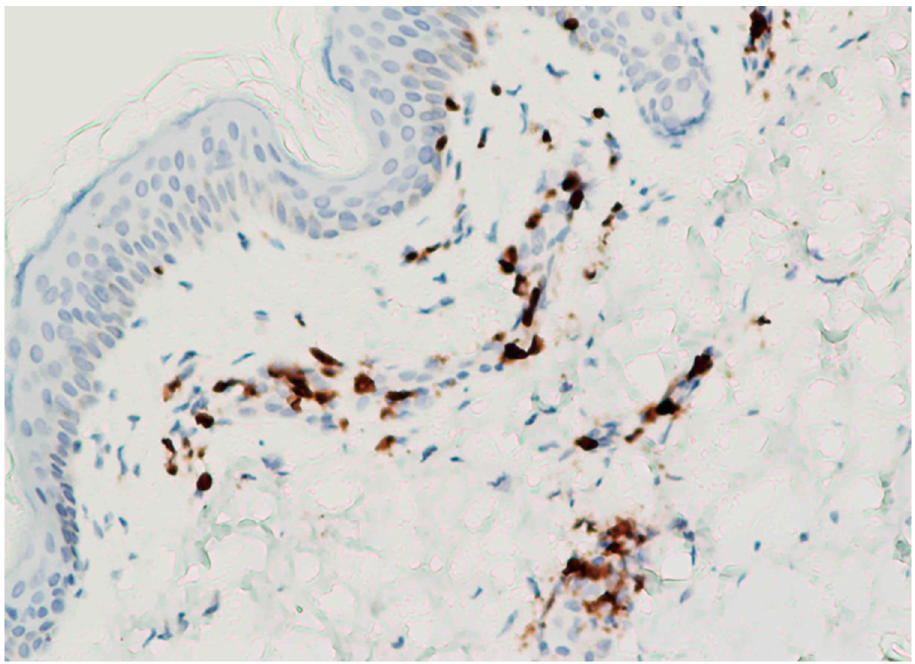
Figure 2. Skin biopsy in a patient who had severe skin rash. The specimen showed inflammatory infiltrates of lymphocytes and neutrophils around the vessels in the upper dermis. Some T lymphocytes, highlighted by the immunostaining of CD3, are noted at perivascular region in the dermis and at the dermo–epidermal junction (100×).